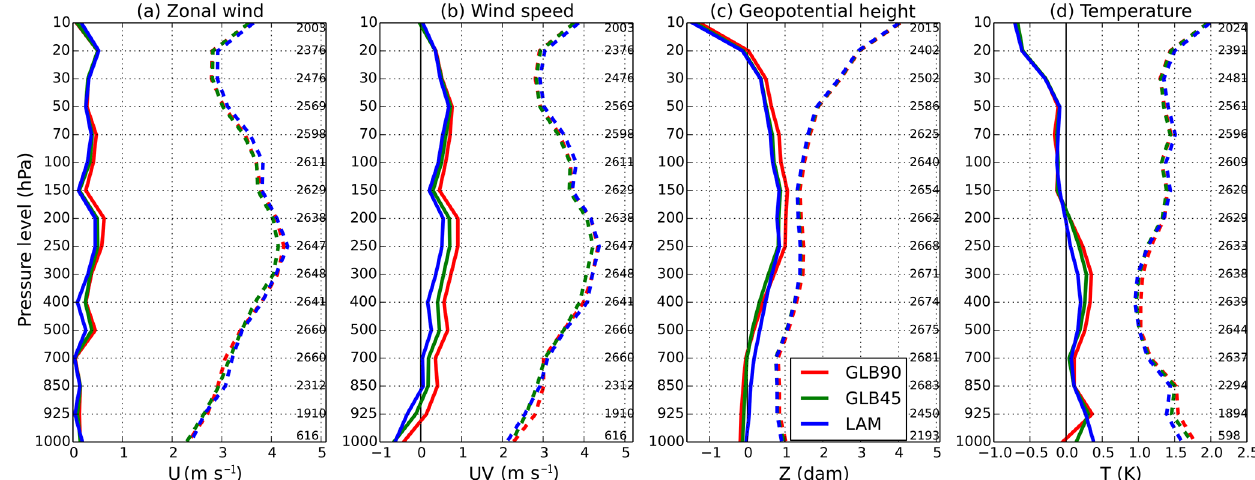
Figure 4. As in Fig. 3, but for December